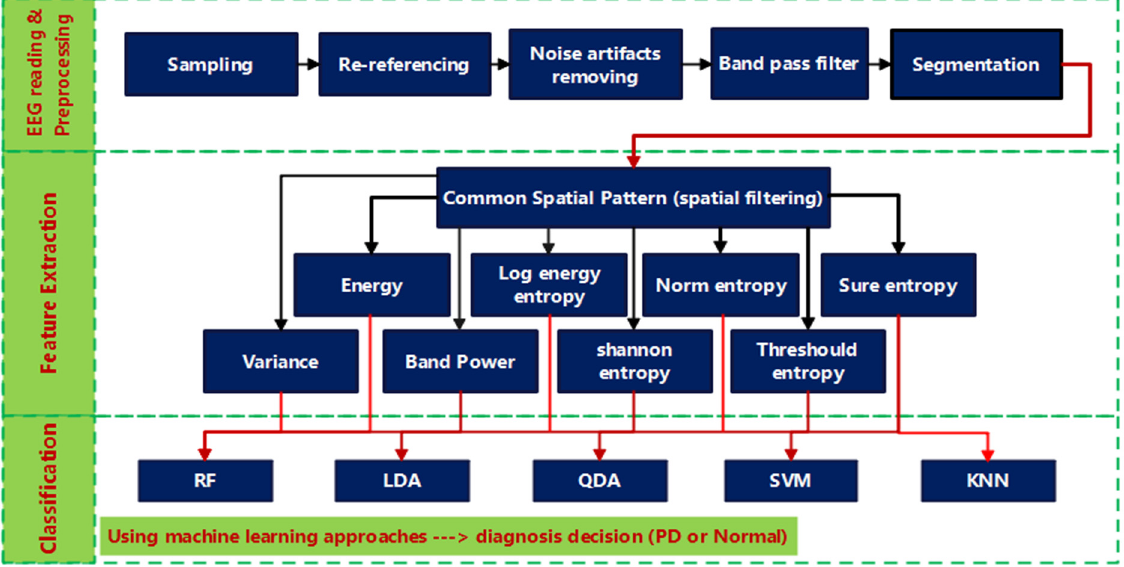
Figure 1. Block diagram of the proposed PD CSP-based classification method.